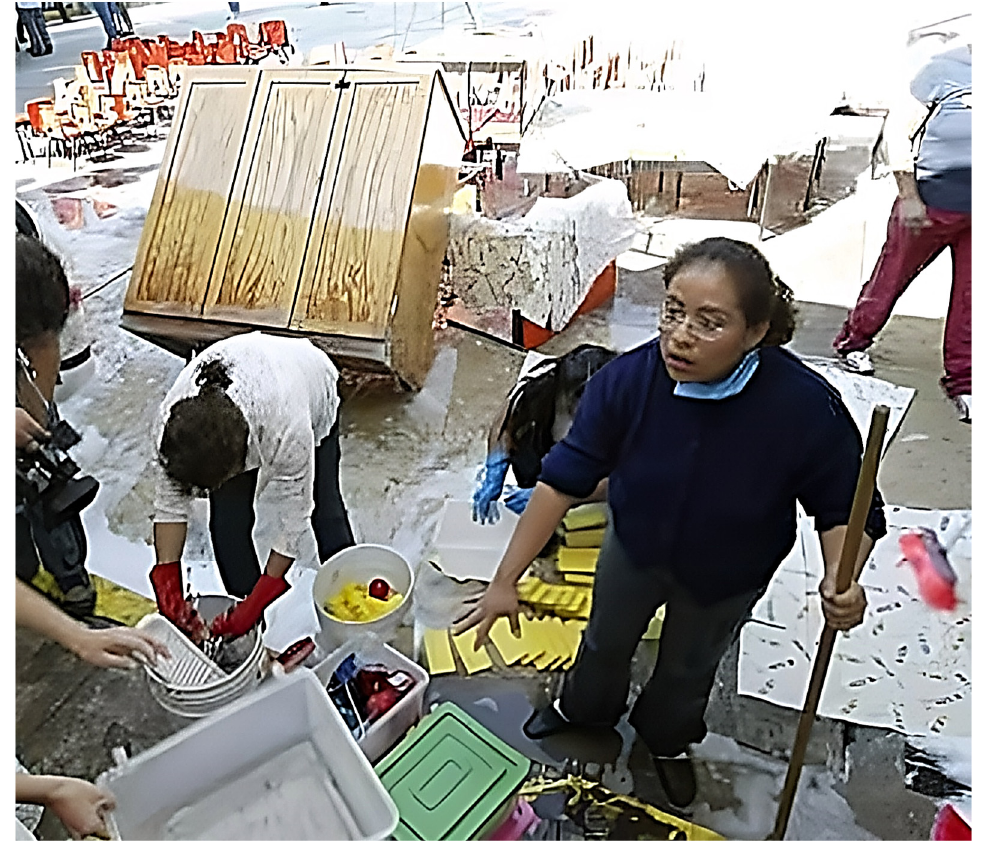
Figure 1. Water depth reached, observed on furniture at the affected site after flood event of 30 October 2009. Source: Google images.